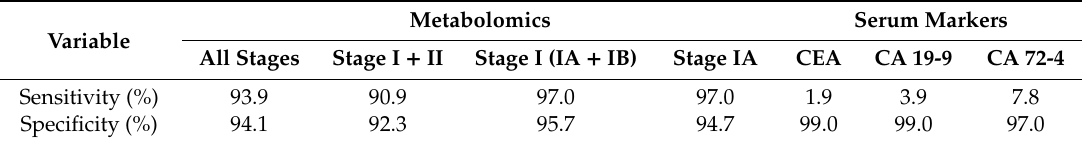
Table 3. Comparison of sensitivity and specificity of conventional modalities and metabolomics profiling for early-stage and locally advanced gastric